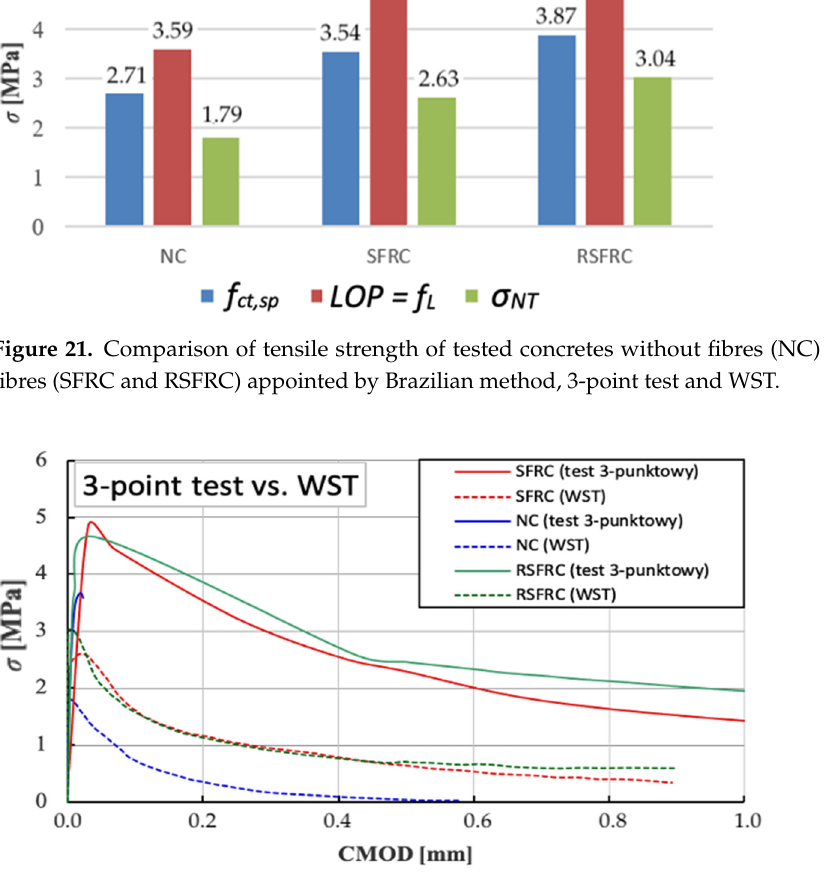
Figure 22. Comparison of σ -CMOD diagrams determined in the bending tests (3-point test) ver- sus wedge splitting test (WST).